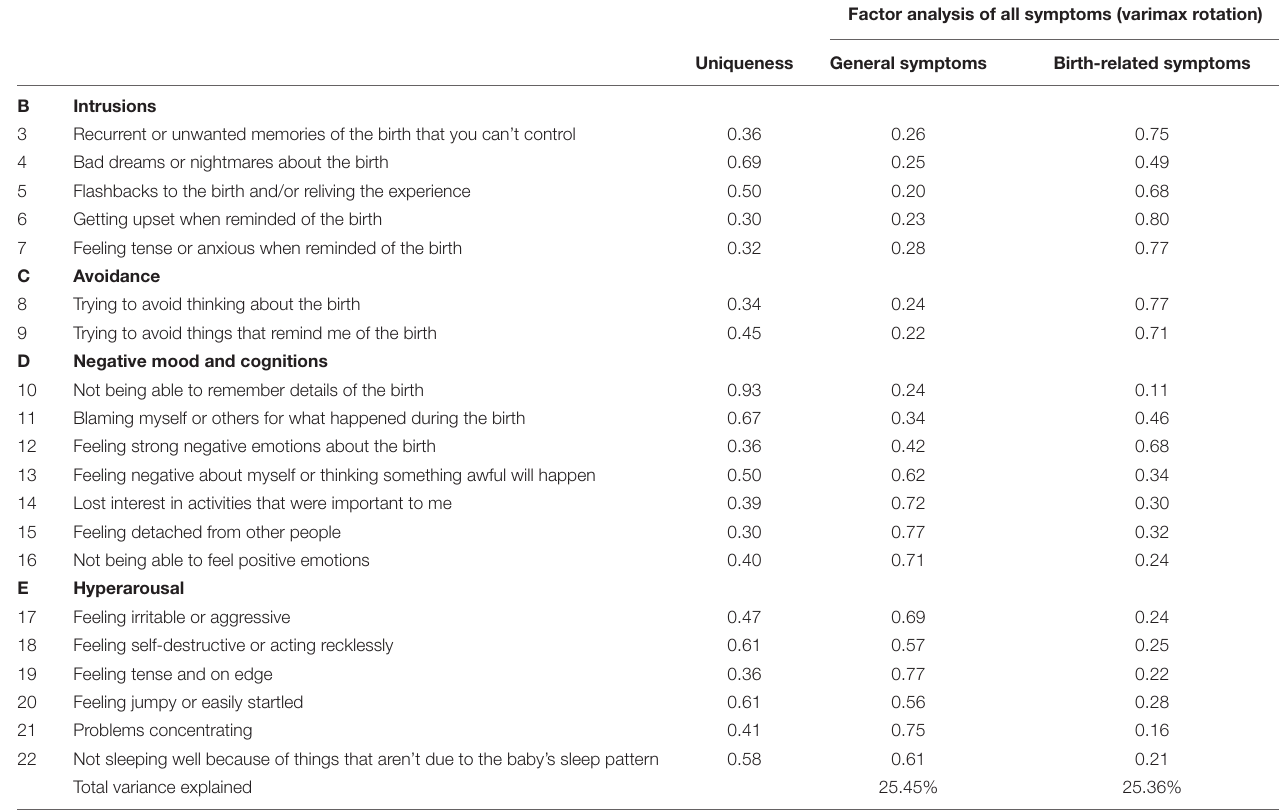
TABLE 5 | Factor structure of the City BiTS (Partner version).